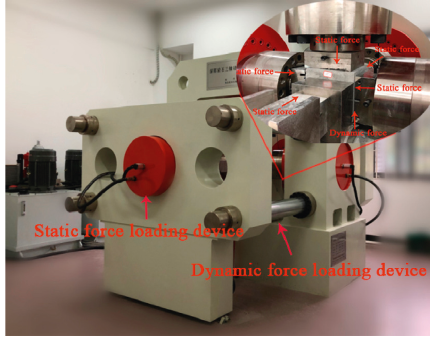
Figure 4: Triaxial test system. Table 1: Physical-mechanical parameters of the original rock and the similar material.